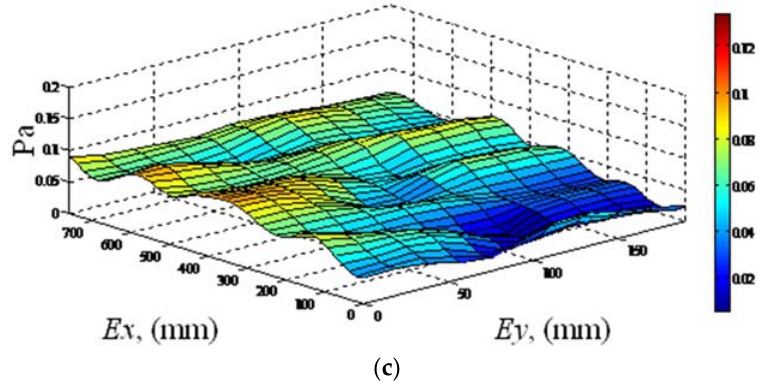
Figure 28. Sound field measurements results: ( a ) incident free field (only specimen supporter in the space) as a reference sound field; ( b ) uncloaked object; ( c ) cloaked object.